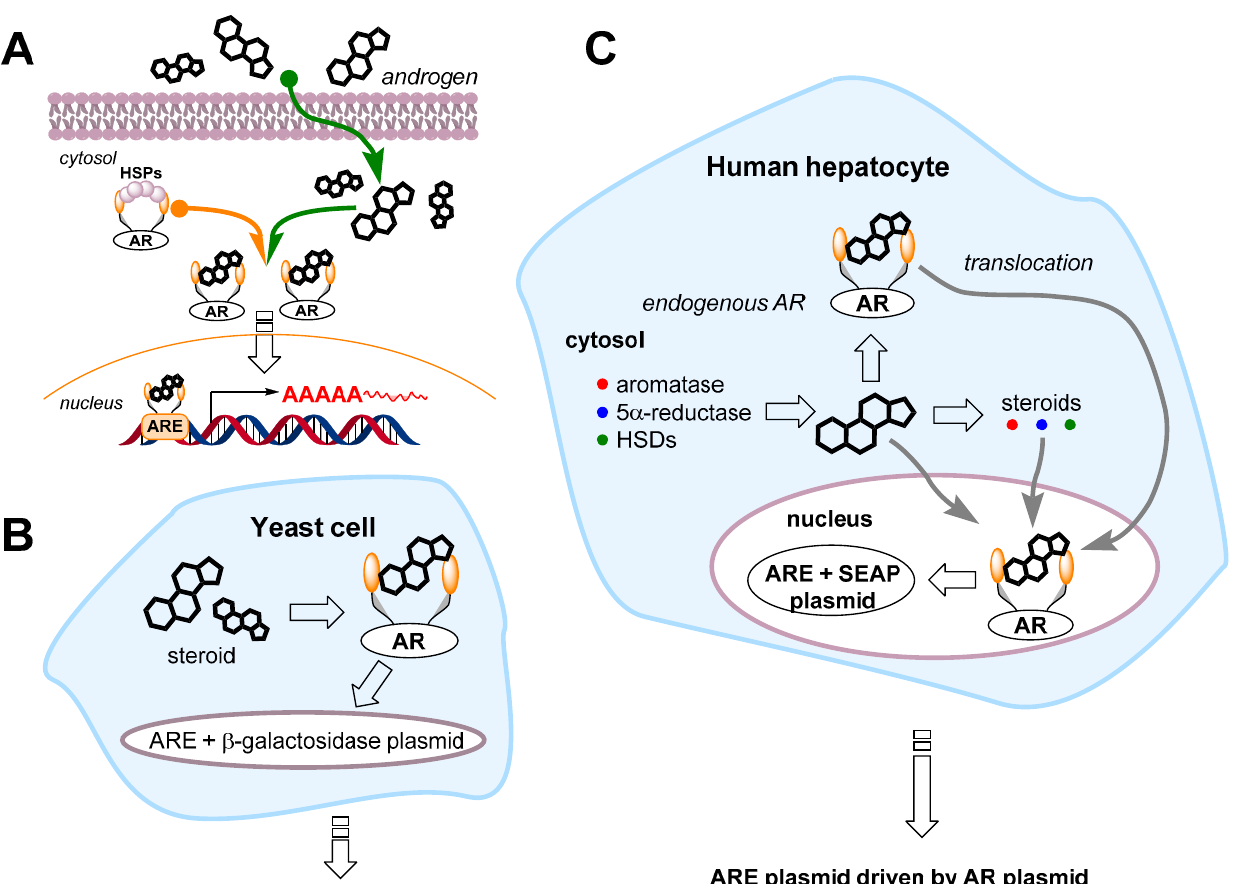
Figure 7. A diagram depicting the androgen response in cells. ( A ): androgens cross the cell plasma membrane to the cytosol and bind to the androgen receptor (AR). In the cytosol, the AR is held by heat shock proteins (HSPs) and other cofactors. Once androgens are bound to the AR, a conformational change is induced. The AR gets rid of inhibitory factors to form an androgen/AR complex. The complex translocates to the cell nucleus, and the receptor dimerizes and binds to the androgen response elements (AREs) located in the regulatory regions of target genes. When bound to the deoxyribonucleic acid (DNA), the AR enhances gene transcription by the ribonucleic polymerase. Yeast ( B ) and mammalian ( C ) cell-based androgen bioassays. The assays are based on the transfection of two plasmid DNAs: The first is the androgen receptor (AR) expression system providing AR expression in cells (yeasts do not express any endogenous ARs, and hepatocytes express them only at a minimal level). The second vector is the ARE-driven reporter gene vector. The most efficient reporter genes are β -galactosidase and secreted alkaline phosphatase (SEAP) in yeast and mammalian cells, respectively. Yeast cells do not express androgen-metabolizing enzymes, while human hepatocytes express a variety of them, including 5 α -reductase, aromatase, and hydroxysteroid reductase (HSD) [115].